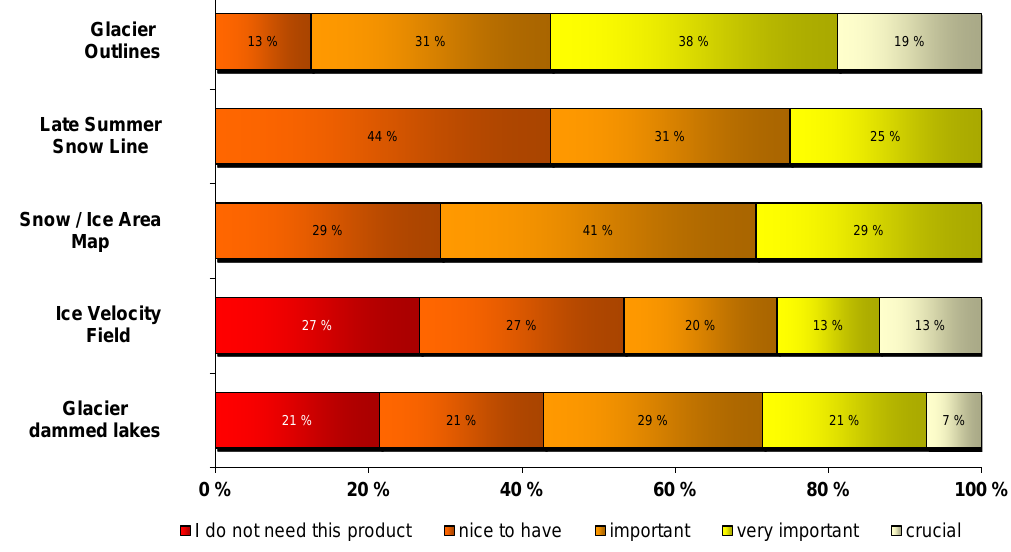
Figure 5. Relevance of glacier